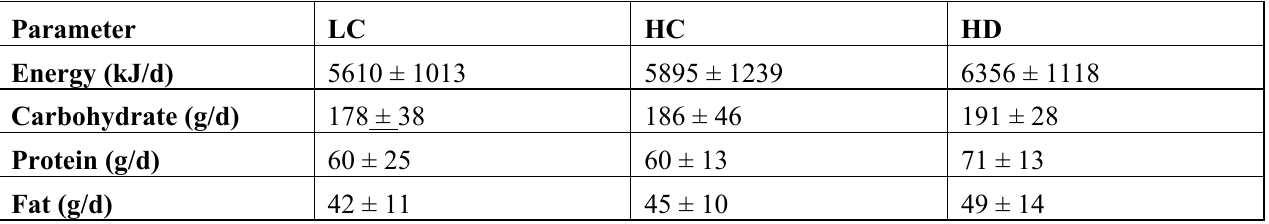
Table 3. Self-reported energy and macronutrient intake during intervention 1